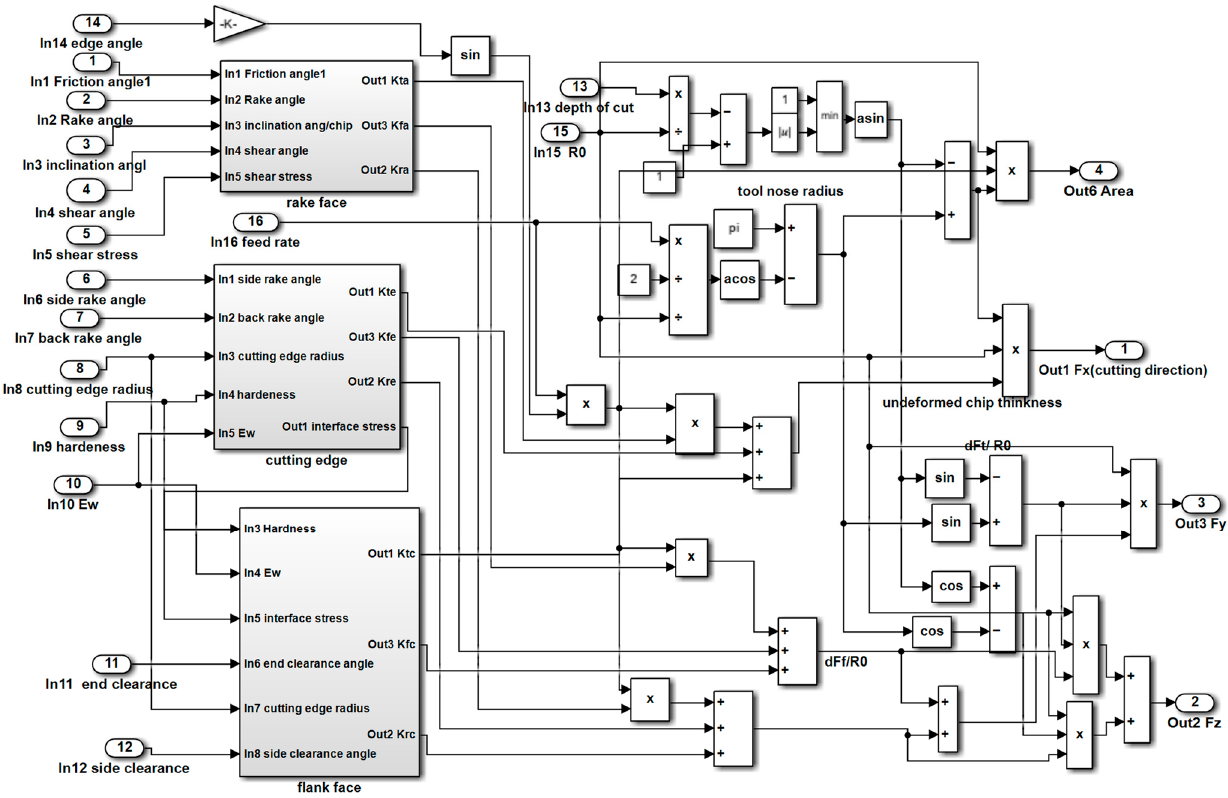
Figure 4. Simulink model of the dynamic cutting forces.